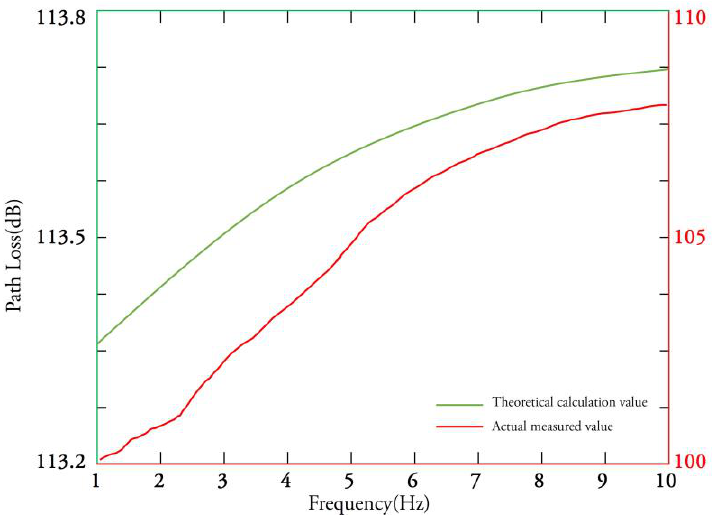
Figure 8. Comparison of theoretical calculation value and actual measurement value of path loss at 1–10 Hz frequency.